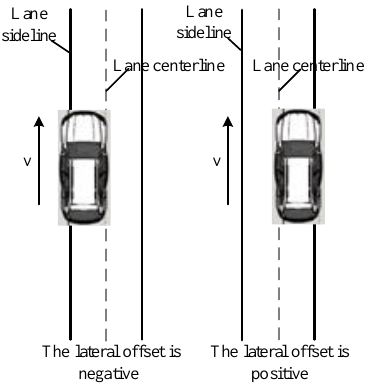
Figure 5. The meaning of positive and negative values of lateral offset.